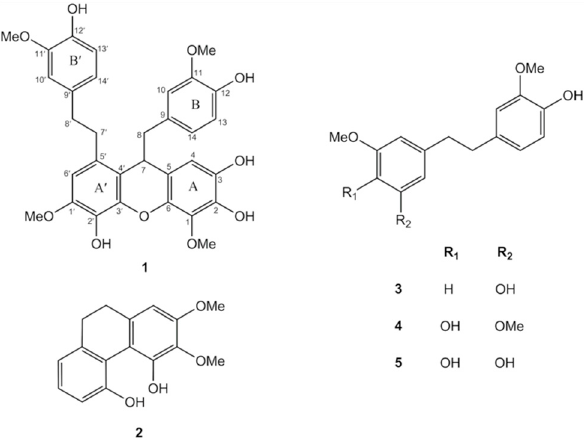
Figure 1. Structures of compounds 1–5 isolated from the EtOAc extract of D. pachyglossum.